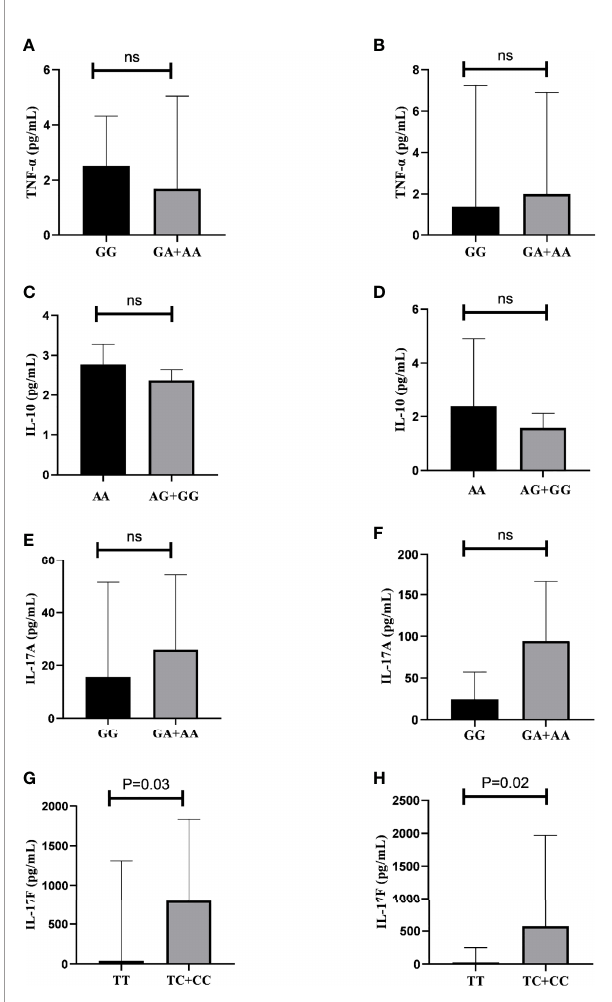
TABLE 5 | Analysis of IL10 gene polymorphisms (rs1800896) in AS patients separated according to clinical data. Clinical data